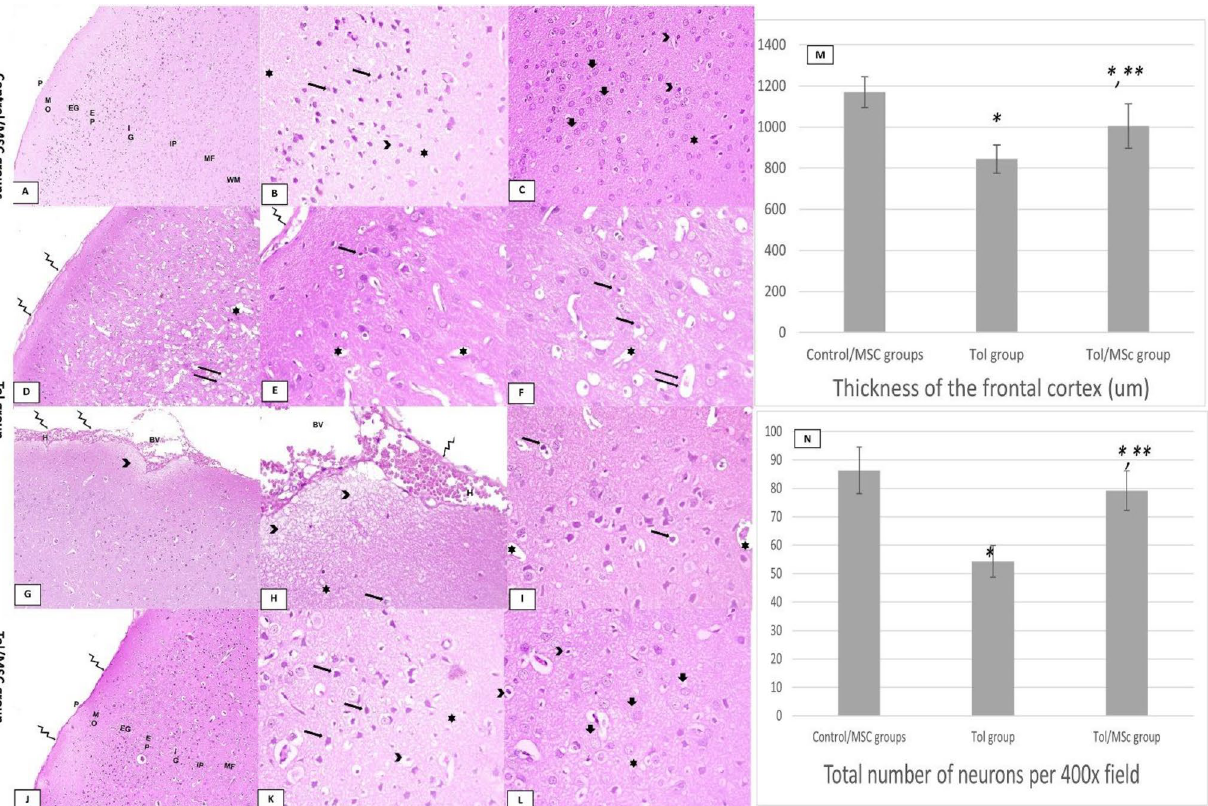
Figure 3. H&E Photomicrographs of the cerebral tissue. ( A ) A 100 × H&E micrograph of control and MSC groups presenting the layers of the cerebral cortex; outer molecular layer (MO), external granular layer (EG), external pyramidal layer (EP), internal granular layer (IG), internal pyramidal layer (IP), and multiform layer (MF), in addition to white matter (WM), pia matter thin and normally attached to the cortex (p), ( B , C ) a 400 × H&E micrographs exhibiting the pyramidal cells characterized by basophilic cytoplasm and apical processes (arrows), the granular cells showing vesicular and prominent nucleoli (thick arrows), the glia cells showing dense small nuclei (arrowheads), and a pink neuropil homogenous background (star). Photomicrographs taken from toluene-treated rat showing ( D , G 100 × H&E, E , F , H , I 400 × H&E); meninges showing signs of inflammation with inflammatory cell infiltration and exudation (zigzag arrows) with congested, dilatated cortical blood vessels (BV) with extravasation and hemorrhage ( H ), neuropil background lost its normal homogeneity with the appearance of vacuolations (stars) and hydropic changes (arrowheads), neurons containing pyknotic hyperchromatic nuclei inside vacuolated cytoplasm (arrows), also, the white matter appeared vacuolated (double arrows). Photomicrographs taken from the toluene and breast milk MSc-treated group ( J ) a 100 × H&E micrograph of showing the different layers of the cerebral cortex; ( K , L ) 400 × H&E micrographs showing the recovery of the basic histological construction, pyramidal cells (arrows), granular cells (thick arrows) with scattered pyknotic nuclei (arrowheads), white matter and neuropil was with fewer vacuolations (stars). Meninges exhibited normal architecture to the cerebral surface (zigzag arrows). ( M , N ) charts showing quantitative assessment of the cortical thickness and total no. of neuron/ filed. Data were expressed as mean ± SD, *significant vs control group, **significant vs toluene group.